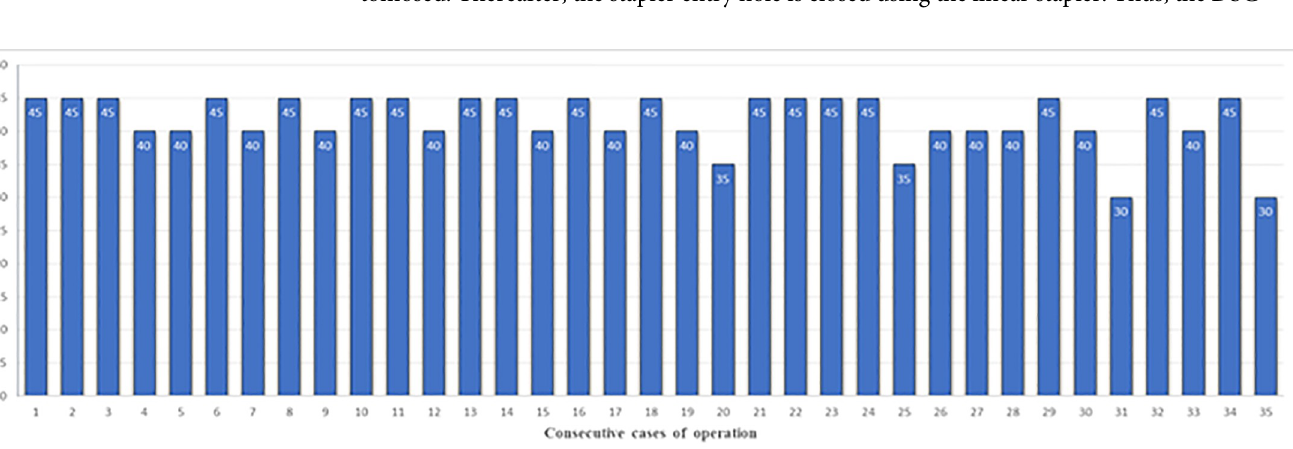
Fig 7. Distribution of staple lengths at linear stapling of the posterior walls of the remnant stomach and duodenum.